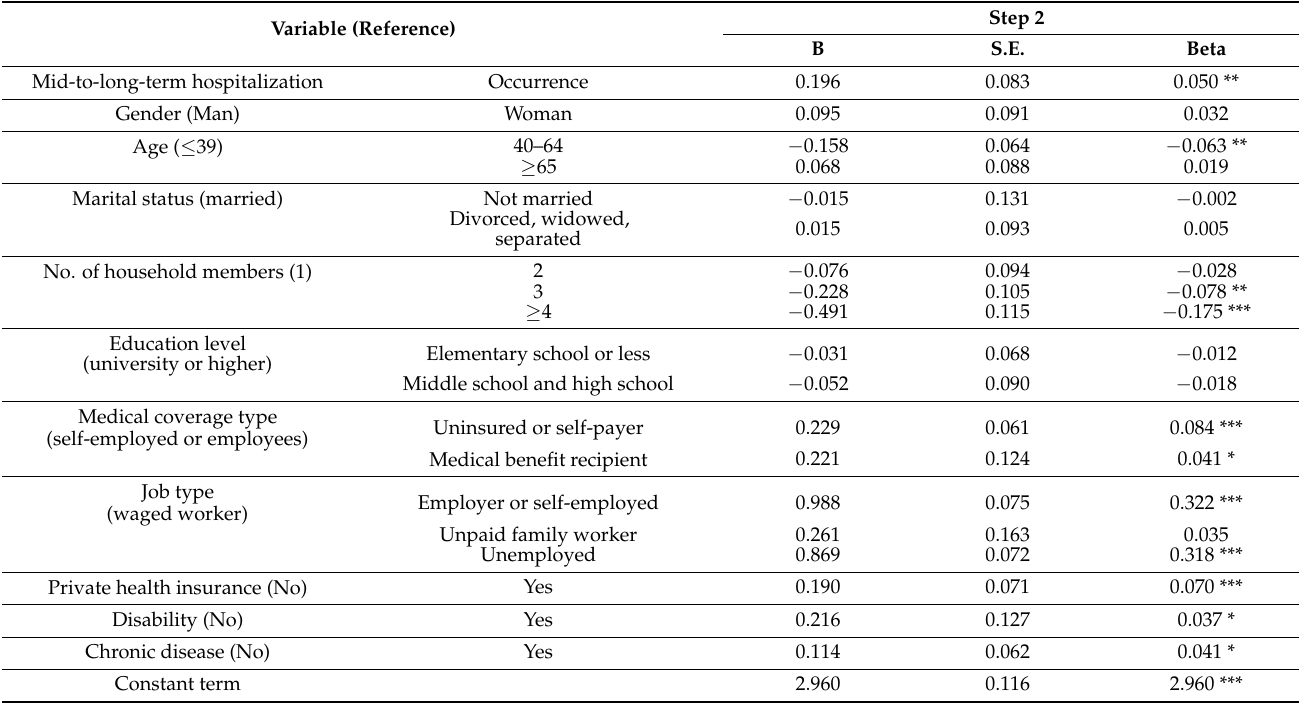
Table 4. The effect of MLTH on the loss of earned income (Model